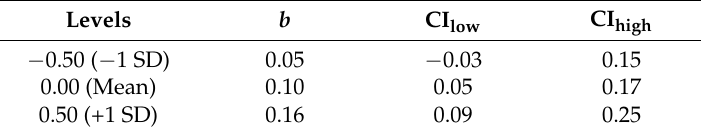
Table 6. Moderated mediation effect of coworker